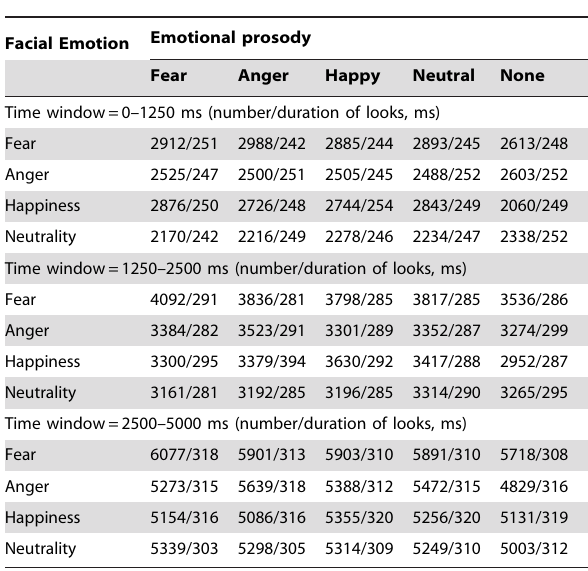
Facial Emotion Emotional prosody Fear